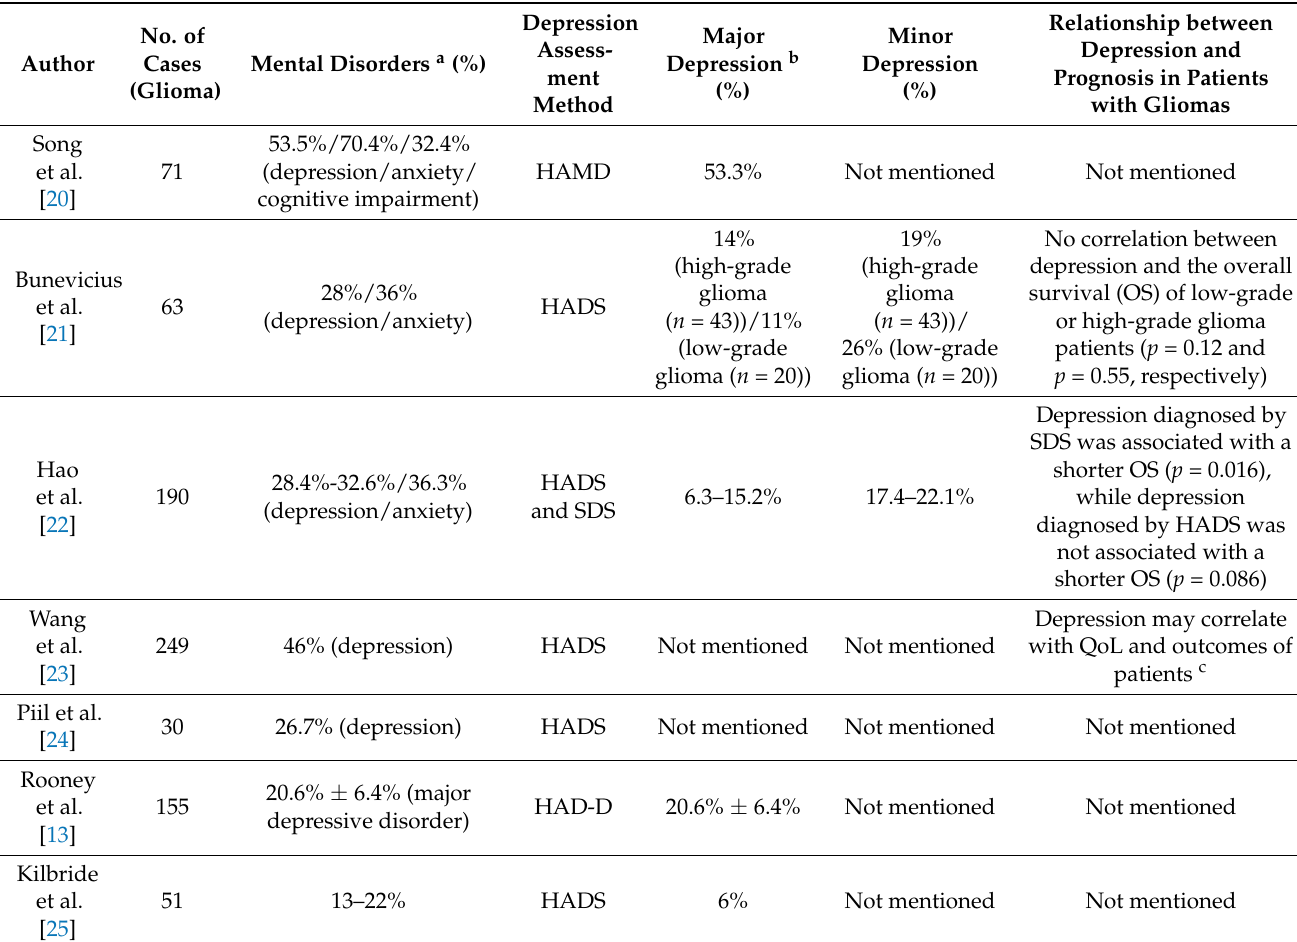
Table 1. Prevalence of mental disorders and depression in